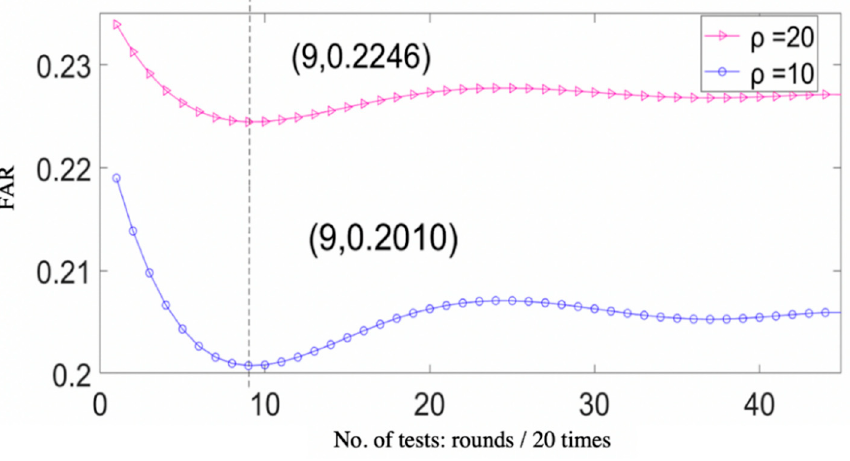
Figure 5. When k = − 3, FAR at ρ = 20 and ρ = 10 is tested as the number of experimental rounds Figure 5. When 𝑘 = −3 , FAR at 𝜌 = 20 and 𝜌 = 10 is tested as the number of experimental rounds increases, and the Q table is updated 20 times per increases, and the Q table is updated 20 times per round.